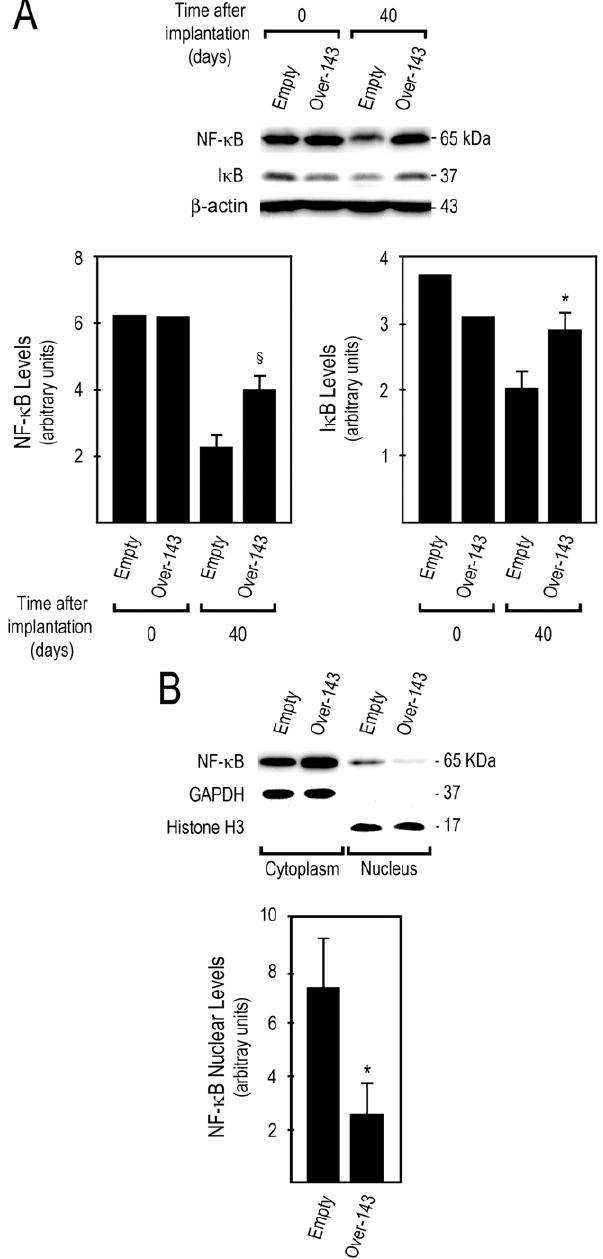
Figure. 4. miR-143 overexpression decreases NF- k B nuclear translocation in tumor xenografts. A, Total proteins were extracted from Over-143 and Empty cells prior to implantation into animals (t=0 days) and from snap frozen tumor xenograft samples (t=40 days), and used to evaluate NF- k B and I k B steady-state levels by Western blot. B, cytosolic and nuclear proteins were extracted from snap frozen tumor xenograft samples (t=40 days; Over-143 and Empty ), to evaluate NF- k B nuclear translocation by Western blot. Results are expressed as mean 6 SEM. * p , 0.05 and 1 p , 0.01 from Empty .